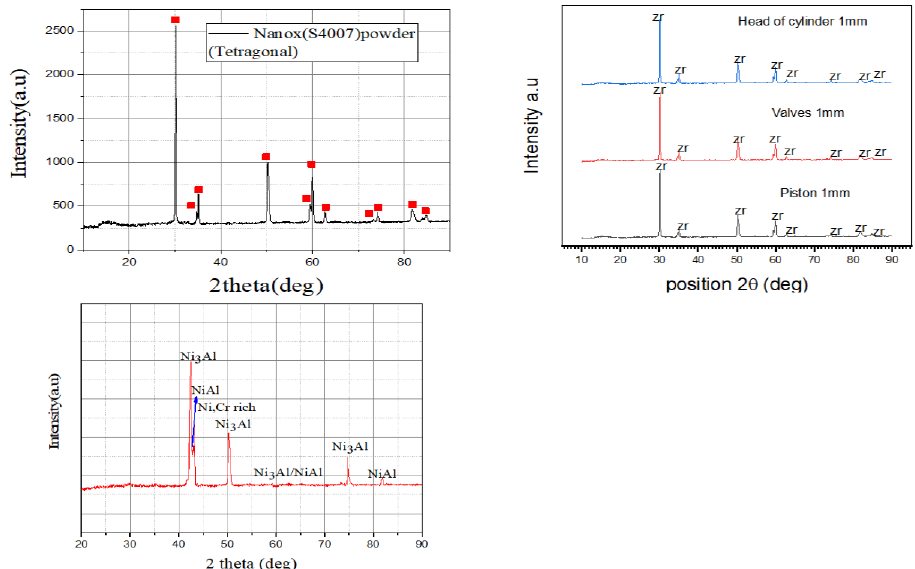
Figure 6: XRD pattern for top YSZ (left) powder, coating the head of cylinder, valves, and piston (right), and NiCrAlY bond powder